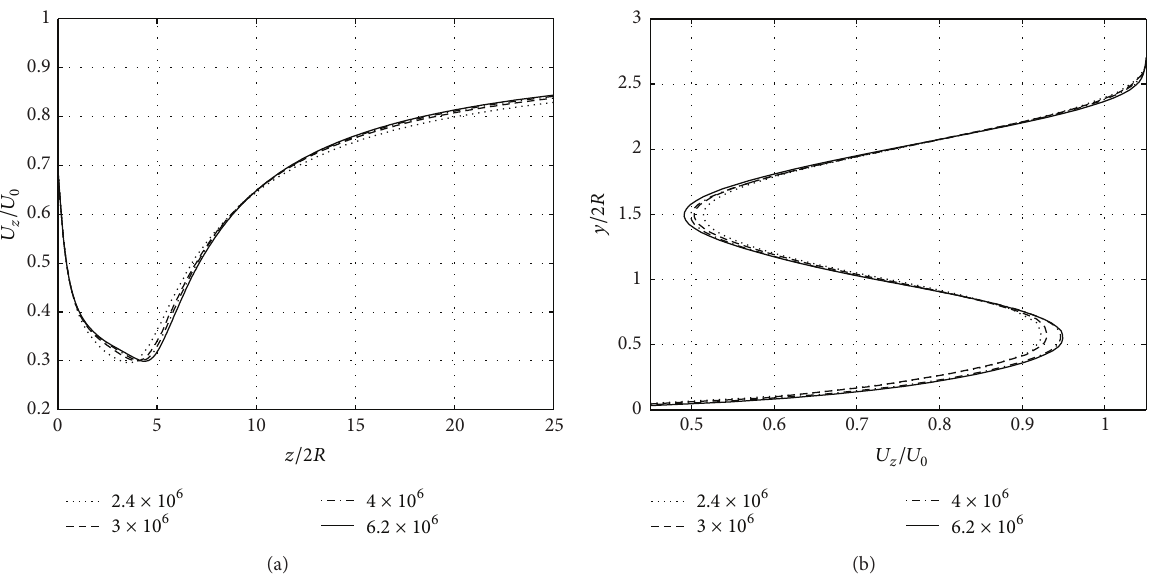
Figure 2: Normalized velocity profiles showing different mesh densities (a) along the centre line and (b) 14𝑅 downstream of the disc.